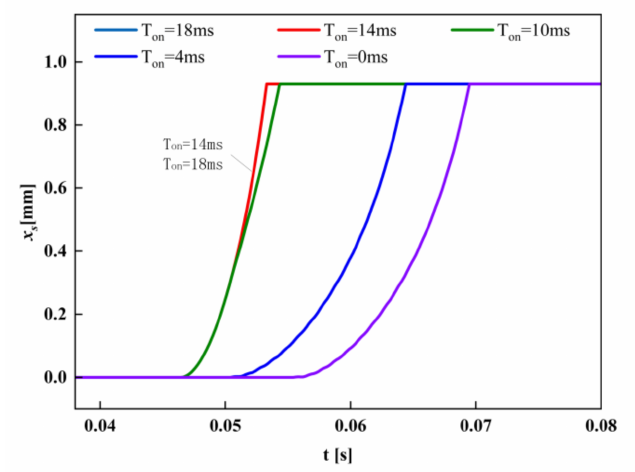
Figure 12. Simulated displacement of the spool under different switching times (T on ) in the opening process.